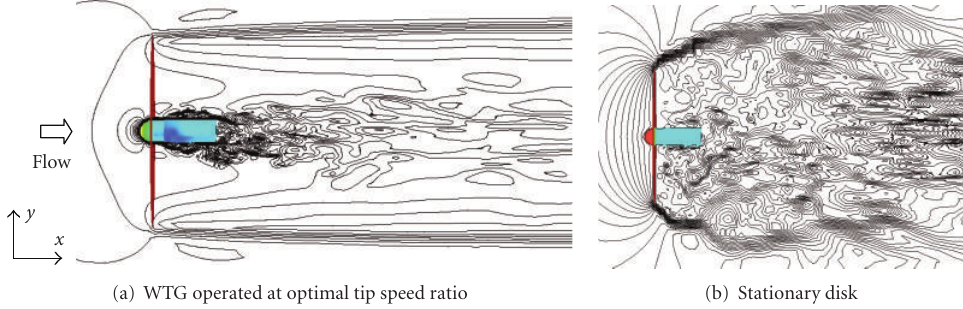
Figure 7: Enlarged view of Figure 5.The colors on the spinner and nacelle represent the dynamic surface pressure. Blue and red indicate the minimum (negative) and maximum values.